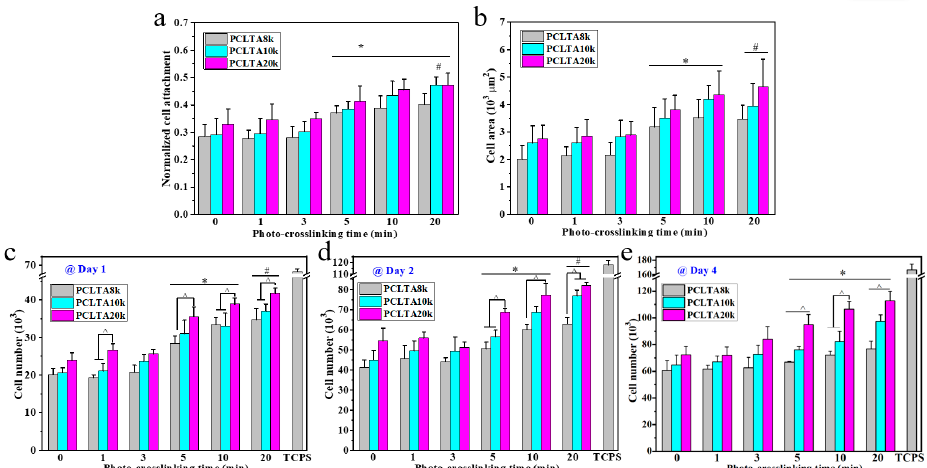
Figure 5. ( a ) Normalized smooth muscle cells (SMC) attachment at 4 h post seeding. ( b ) SMC areas at day 1 post-seeding. ( c – e ) SMC numbers at days 1, 2, and 4 post-seeding on the PCLTAs with di ff erent